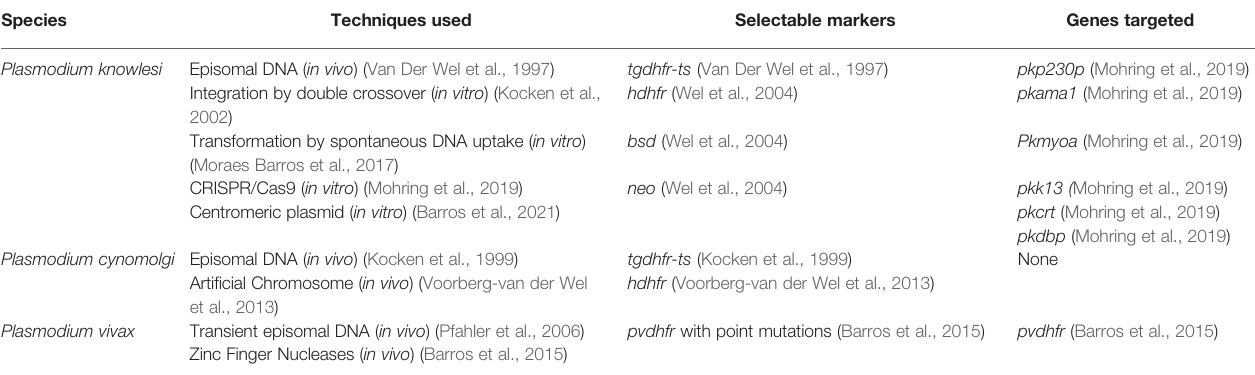
TABLE 1 | Summary of techniques used in non-falciparum Plasmodium transfection studies.